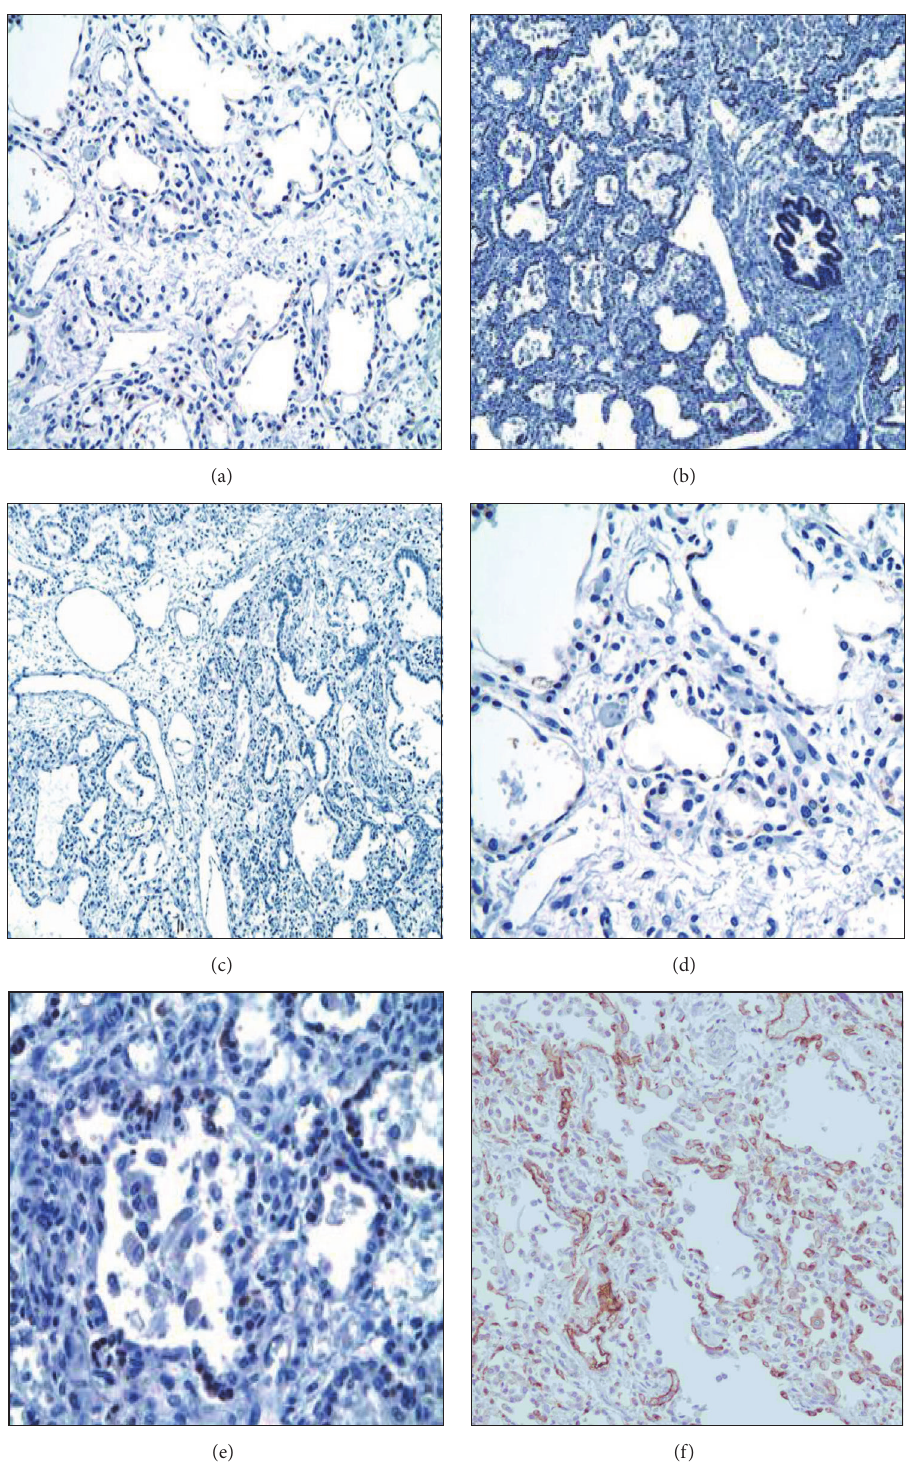
Figure 3: ACD/MPV pulmonary microvasculature lacks SERT expression (3,3 󸀠 -diaminobenzidine, SERT). Representative sections from 5 different ACD cases ((a)–(e)) show absence (no brown stain noted) of SERT staining (200x). (f) Positive control stained with the pan- endothelial marker CD31 (brown stain) to assess pulmonary endothelial cell